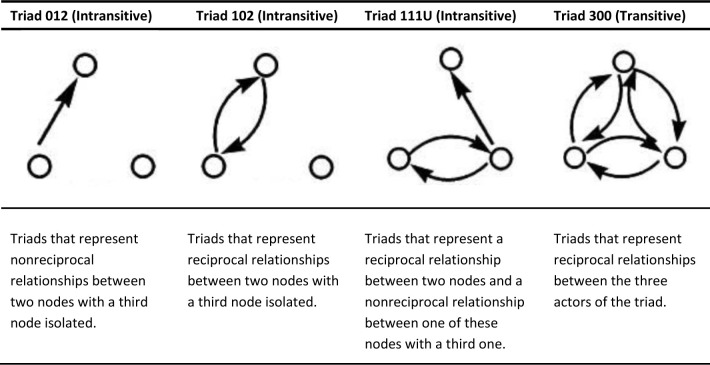
Description of the four most representative triads in this research (T012, T102, T111U and T300).